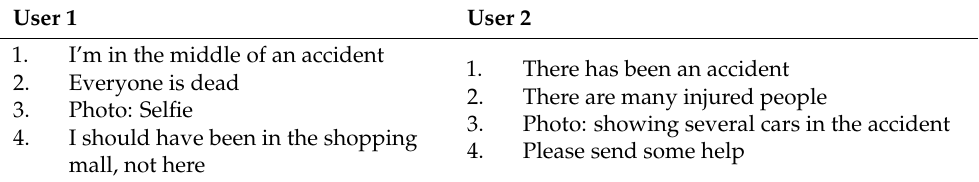
Table 8. Car accident scenario.